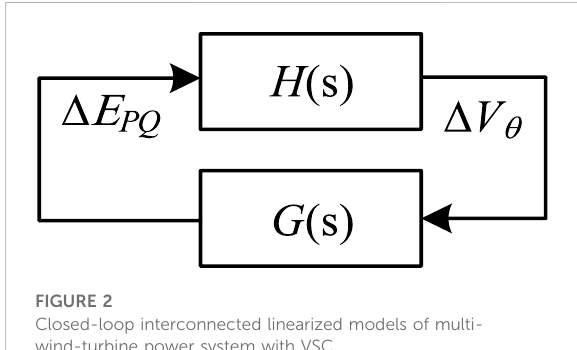
FIGURE 2 Closed-loop interconnected linearized models of multi- wind-turbine power system with